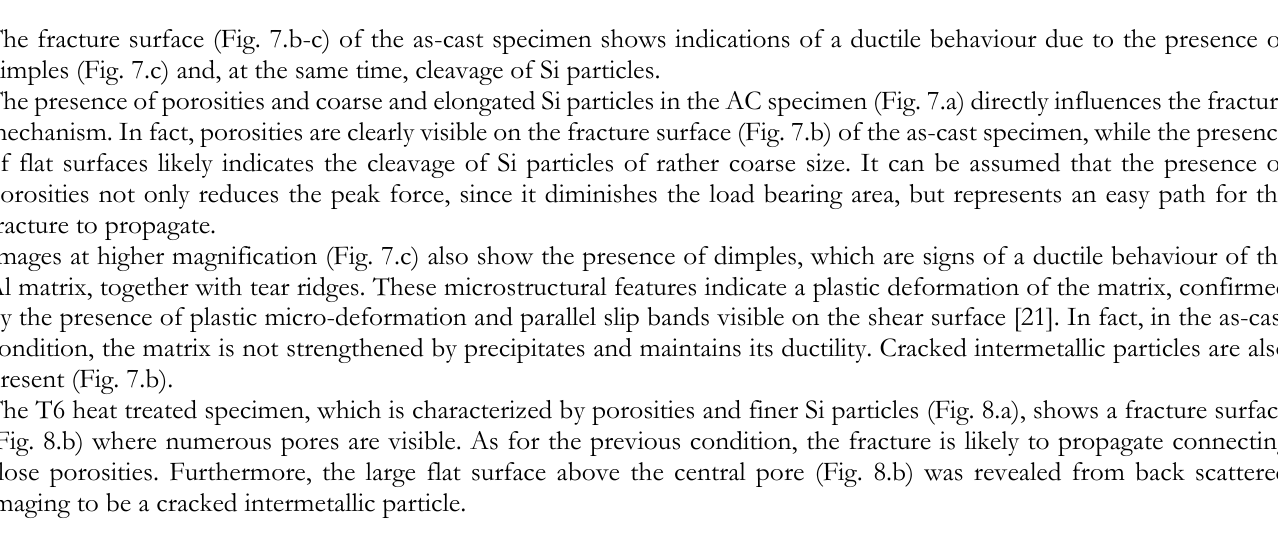
Figure 7: As-cast specimen: (a) microstructure at high magnification by optical microscopy; (b-c) fracture surface by scanning electron